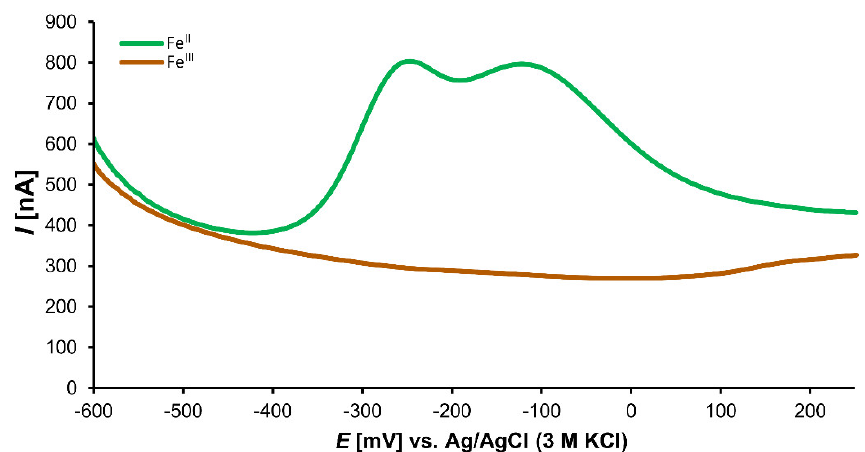
Figure 4. Differential pulse voltammogram of 1 mM solutions of Fe II and Fe III in phosphate buffer (pH 7.4).